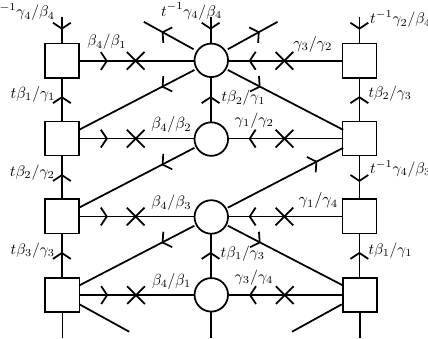
Figure 6 . A combination of a domain wall with SU( k ) (cid:12) (cid:13)ux and a domain wall with SU( k ) (cid:13) (cid:13)ux in the a(cid:14)ne A 3 quiver gauge theory. The total (cid:13)ux becomes F tot = (1 = 2 ; 1 = 4 ; 1 = 4 ; (cid:0) 1) (cid:12) + ( (cid:0) 1 = 2 ; 1 = 2 ; (cid:0) 1 = 2 ; 1 = 2) (cid:13) . The top gauge group has four N (cid:13)avors, which means it is free in the